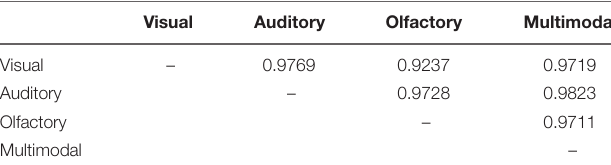
TABLE 2 | The dot product between the densities of the age at event distributions for the four modalities. Visual Auditory Olfactory Multimodal